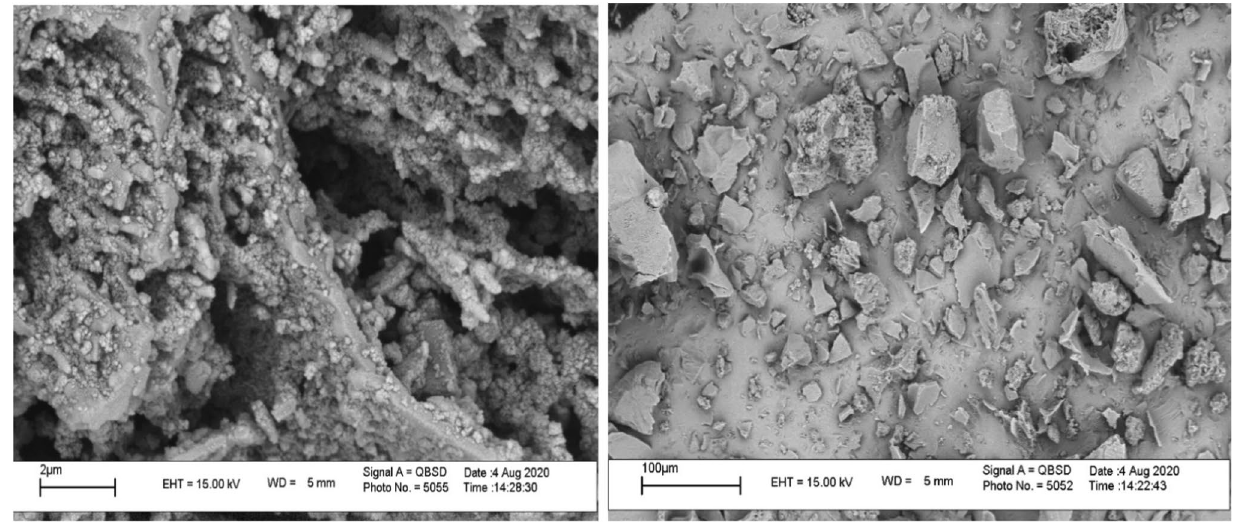
Fig. 2 Scanning electron micrographs (SEM) of PBAC@Fe